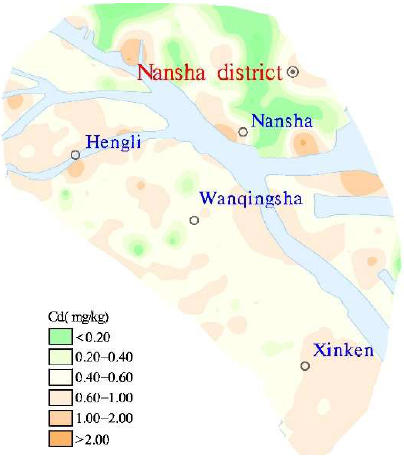
Figure 5. Soil Cd contour distribution.